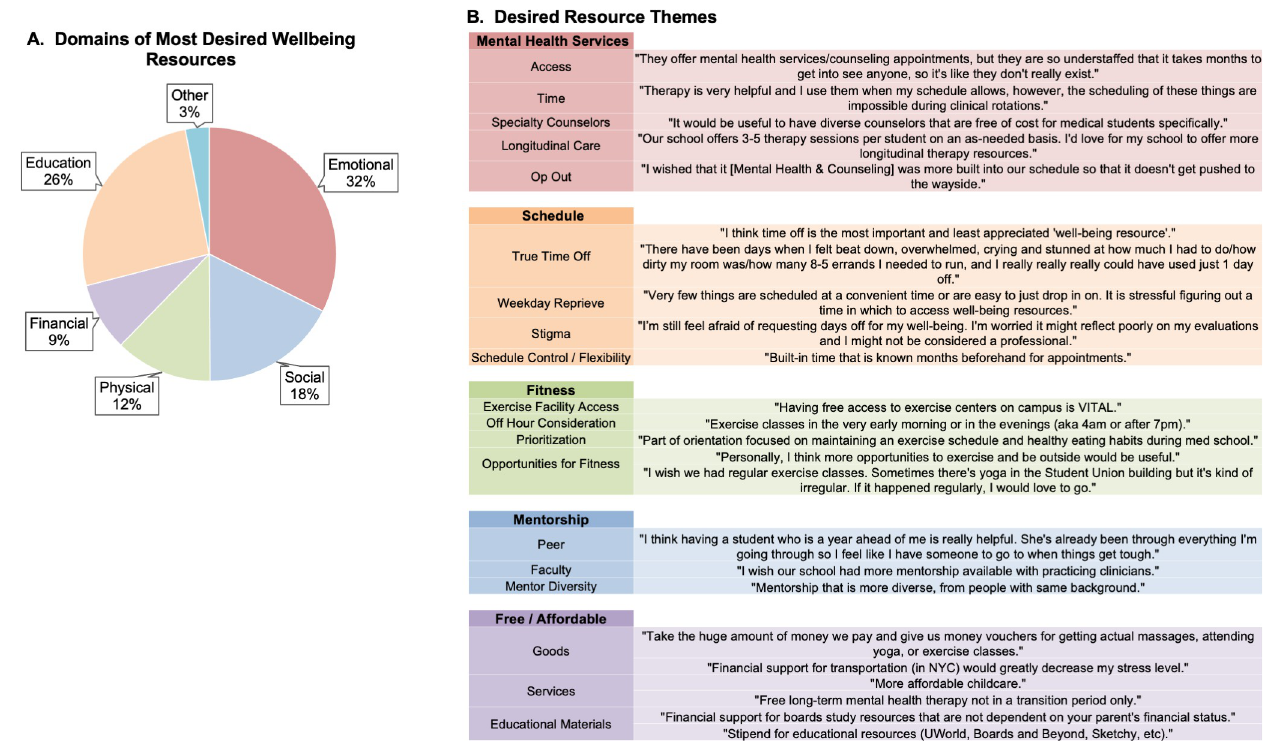
Fig 3. Most desired wellbeing resources by students. Characterization of student free-text responses according to domains of wellbeing (physical, emotional, social, educational, financial, and other) (A). Domain themes and representative quotes based of desired wellbeing resources (B).